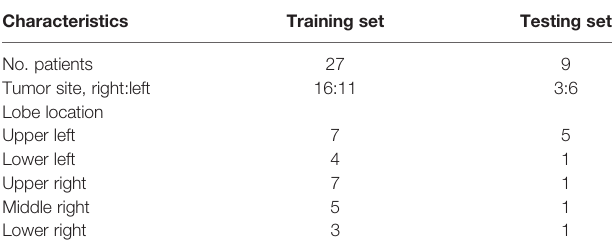
TABLE 1 | Characteristics of patients in the training and testing sets.